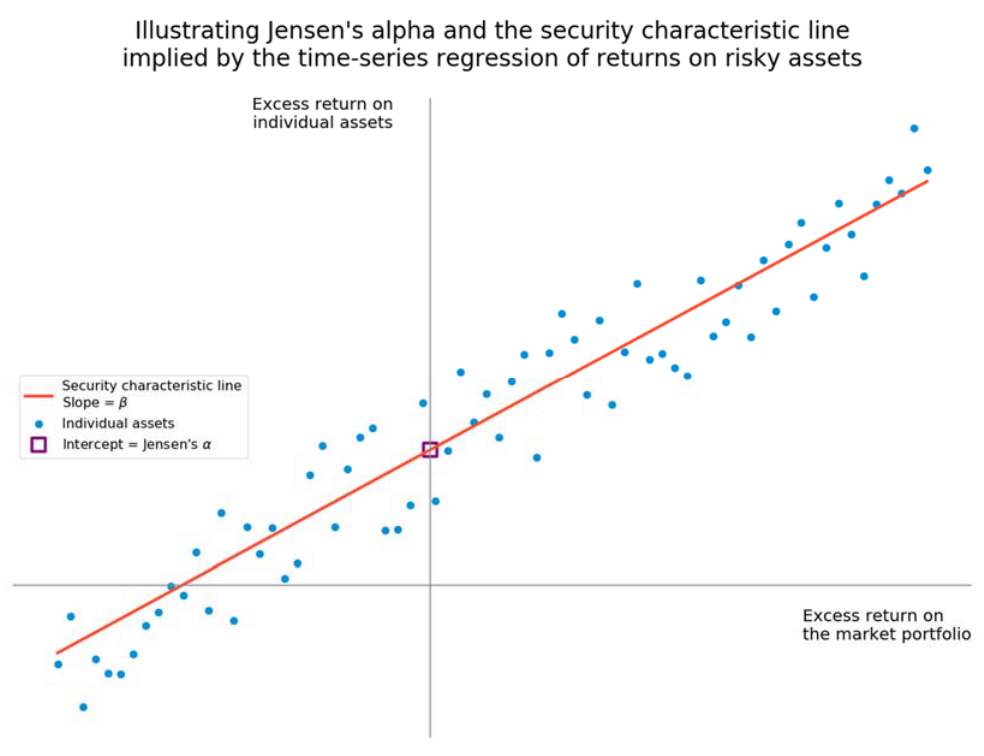
Figure 3. The security characteristic line and Jensen’s α .